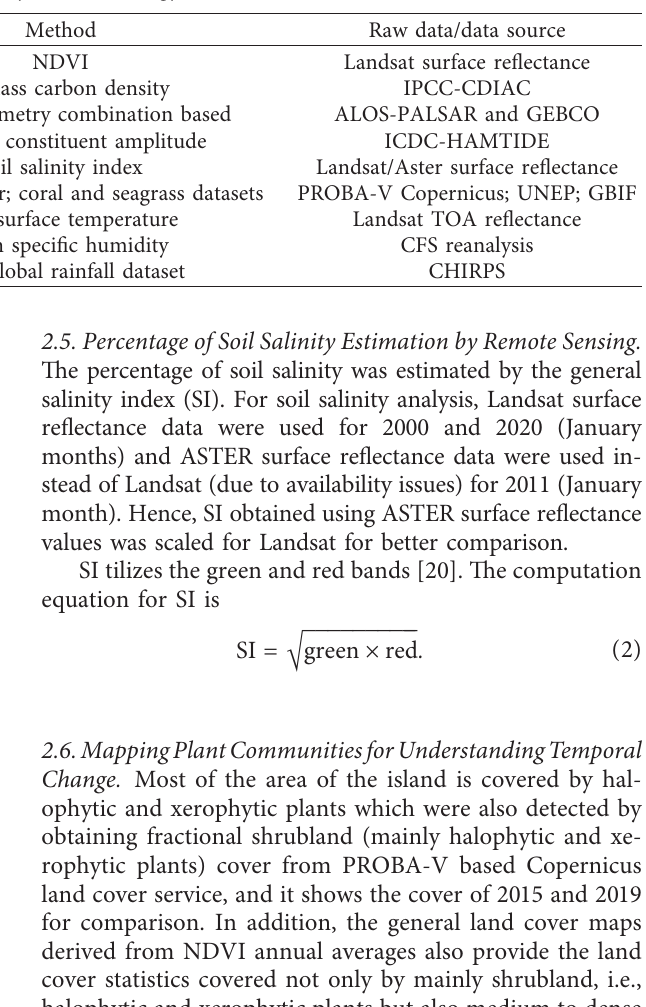
Table 1: Summary of